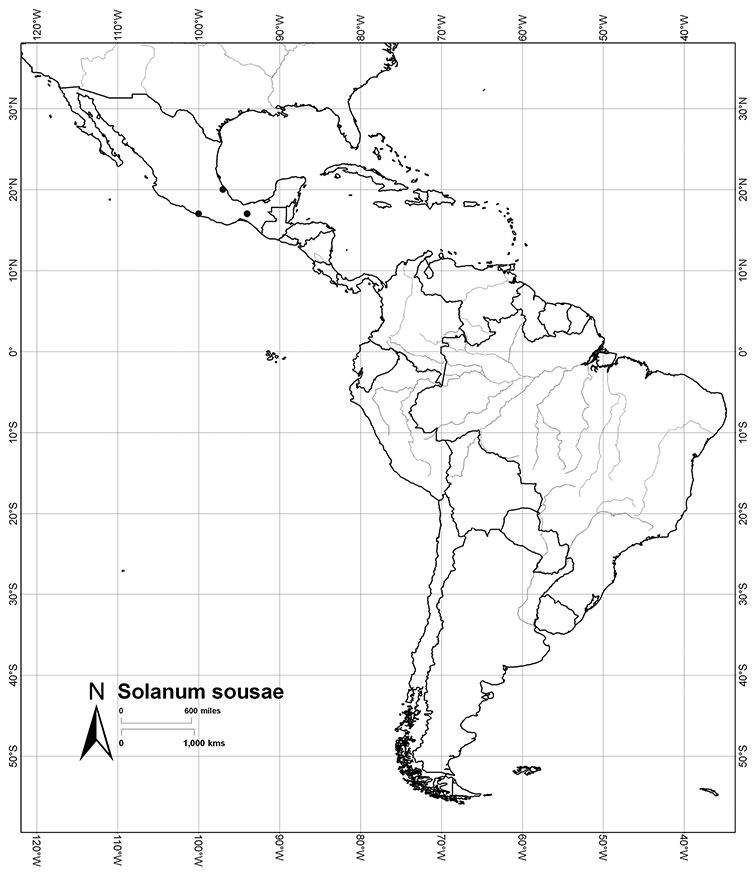
Distribution of Solanum sousae S.Knapp.